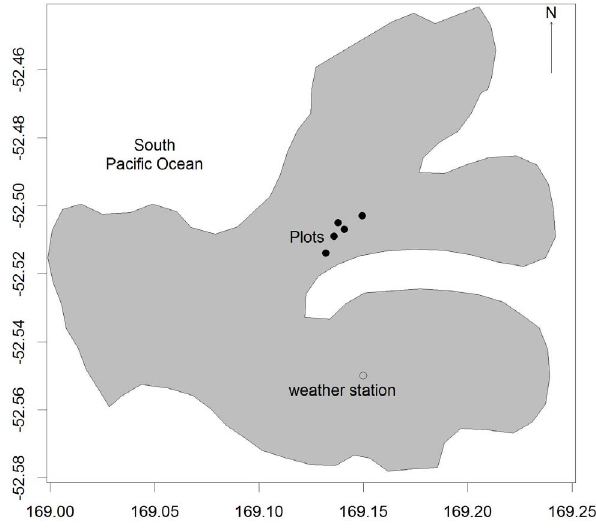
Figure 1. Map of plot and weather station locations on Campbell